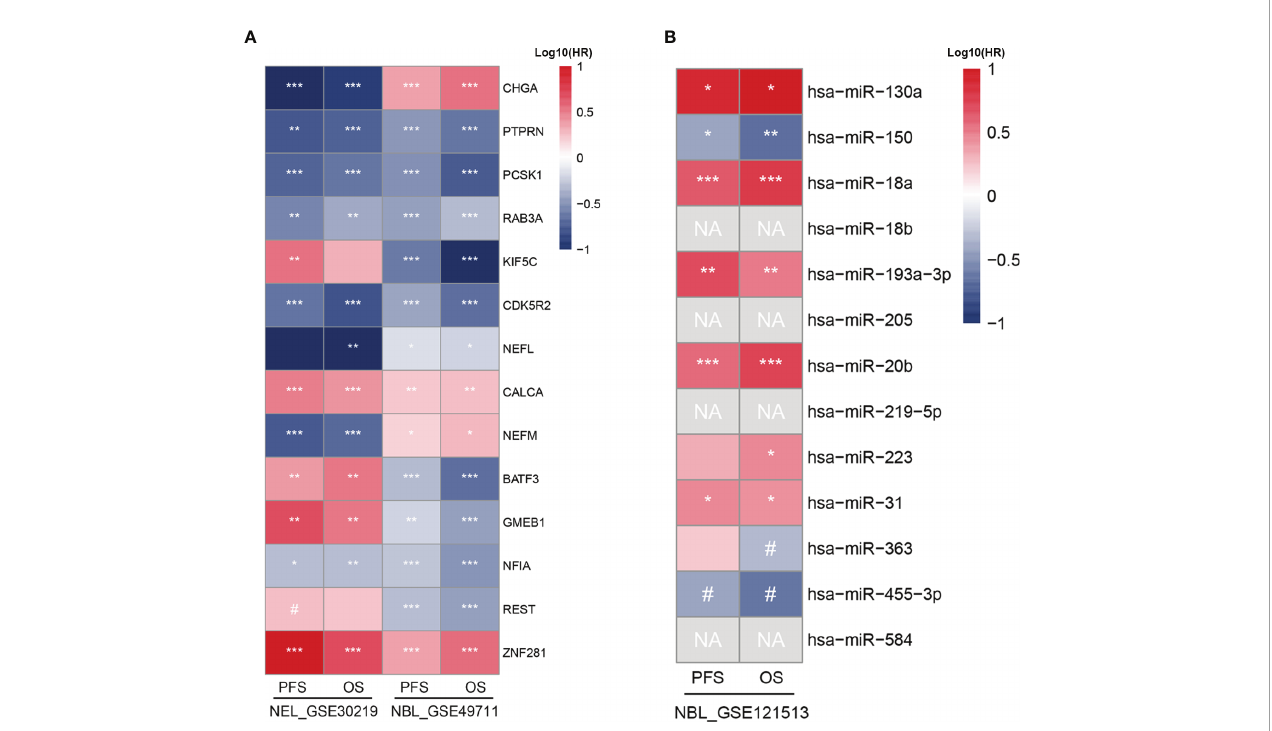
FIGURE 10 Prognostic potential of individual biomarkers in TF-mRNA-miRNA network for neuroendocrine tumors. (A) Heatmap of HR with signi fi cant level regarding the prognostic roles of TFs and hub genes in NEL and NBL. (B) Heatmap of HR with signi fi cant level regarding the prognostic roles of miRNAs in NBL. HR, hazard ratio; NEL, neuroendocrine tumor of lung; NBL, neuroblastoma; PFS, progression-free survival; OS, overall survival; NA, not available. # p < 0.1; *p < 0.05; **p < 0.01; ***p <